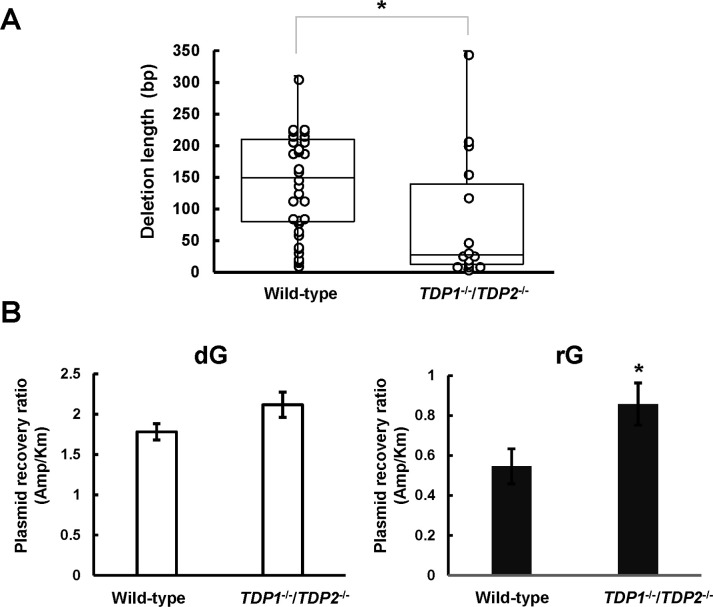
Effect of tyrosyl-DNA phosphodiesterase deficiency on the length of large deletion mutations and the recovery ratio of propagated plasmids.(A) Box plot representing the length of large deletion mutations observed in the indicated genotypes. A significant difference is indicated by an asterisk (*P <0.05). (B) The synthetic closed-circular DNA with or without rG was co-transfected with pST189K into cells. After 48 h of incubation, the replicated plasmids were recovered and introduced into the KS40/pOF105 strain. The transformed E. coli cells were plated onto LB plates with ampicillin (150 μg/mL) or kanamycin (50 μg/mL) in the presence of chloramphenicol (30 μg/mL). The numbers of ampicillin-resistant colonies relative to those of kanamycin-resistant colonies are presented. Values presented are the mean ± SE from six independent cultures derived from two transfections. A significant difference is indicated by an asterisk (*P <0.05).